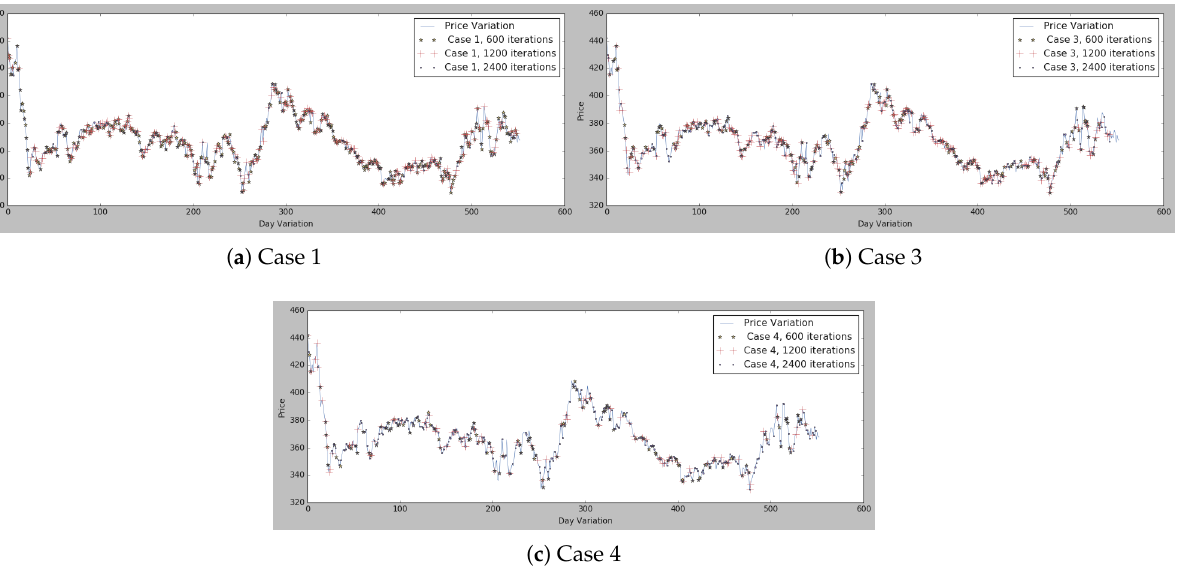
Figure 8. Table 5 for three selected